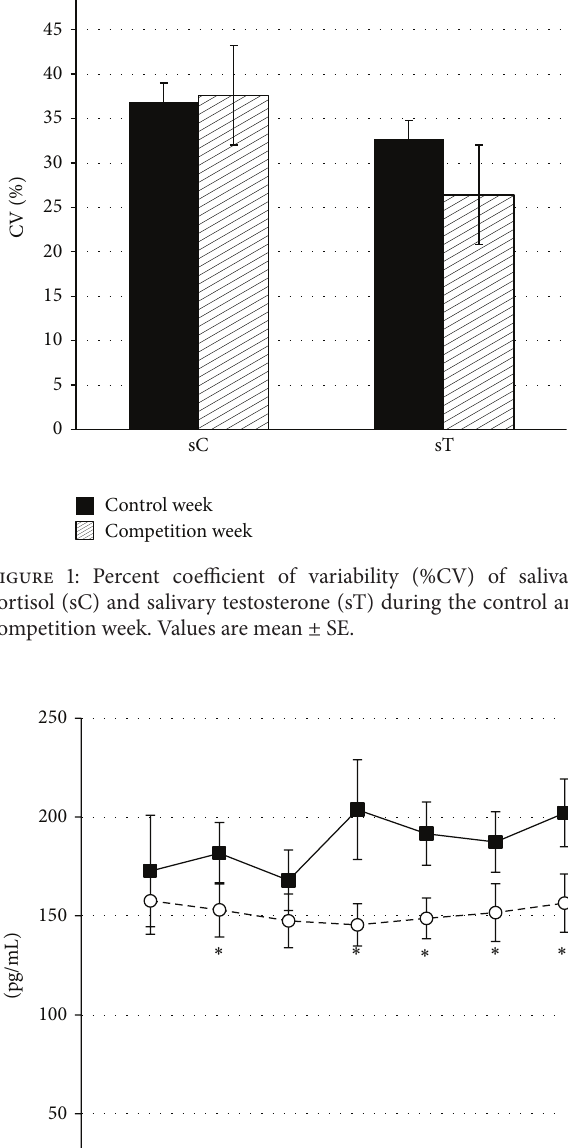
( 𝑛 = 18 ). A similar pattern of results was observed whether analysis was performed on the total cohort of swimmers or on the subsample with no URTI symptoms. This indicates that the results were independent of the initial immune state of the